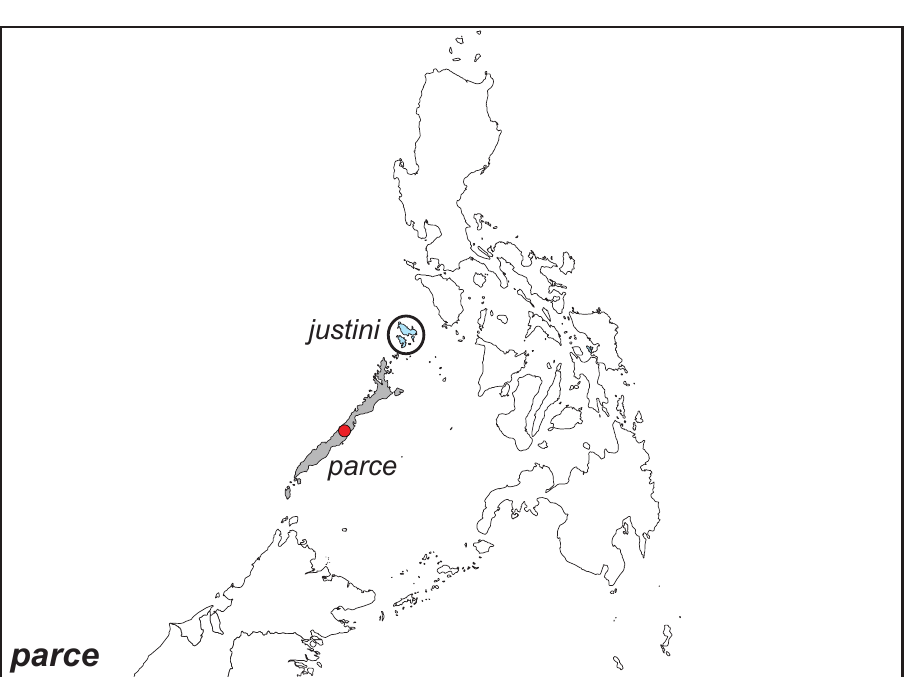
Figure 45. Distribution map of Elymnias harterti .